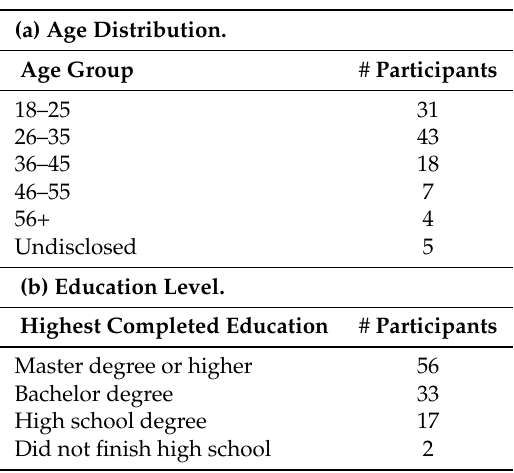
Table 1. Participant statistics.